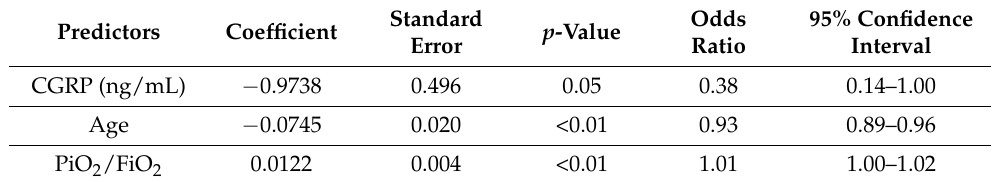
Table 7. Multivariate stepwise logistic regression of plasma CGRP concentration at baseline (t0) predicting a faster clinical recovery (discharge and/or NEWS2 ≤ 2 for at least 24 h within 14 days of hospitalization), including demographic and disease severity variables. The variables that entered the model are reported in the table. The gender and NEWS2 score did not enter the model.